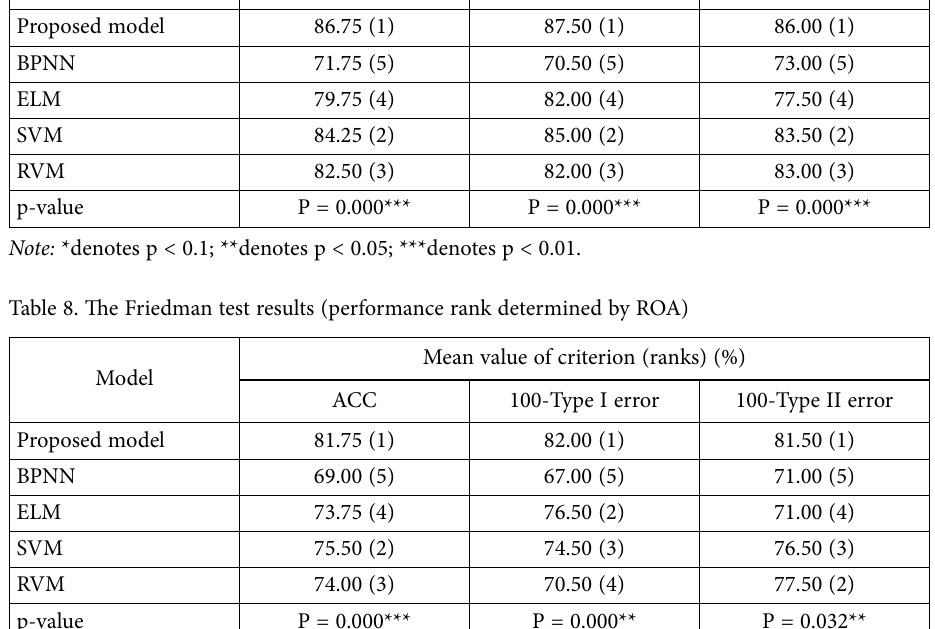
Table 7. The Friedman test results (performance rank determined by original DEA) Model